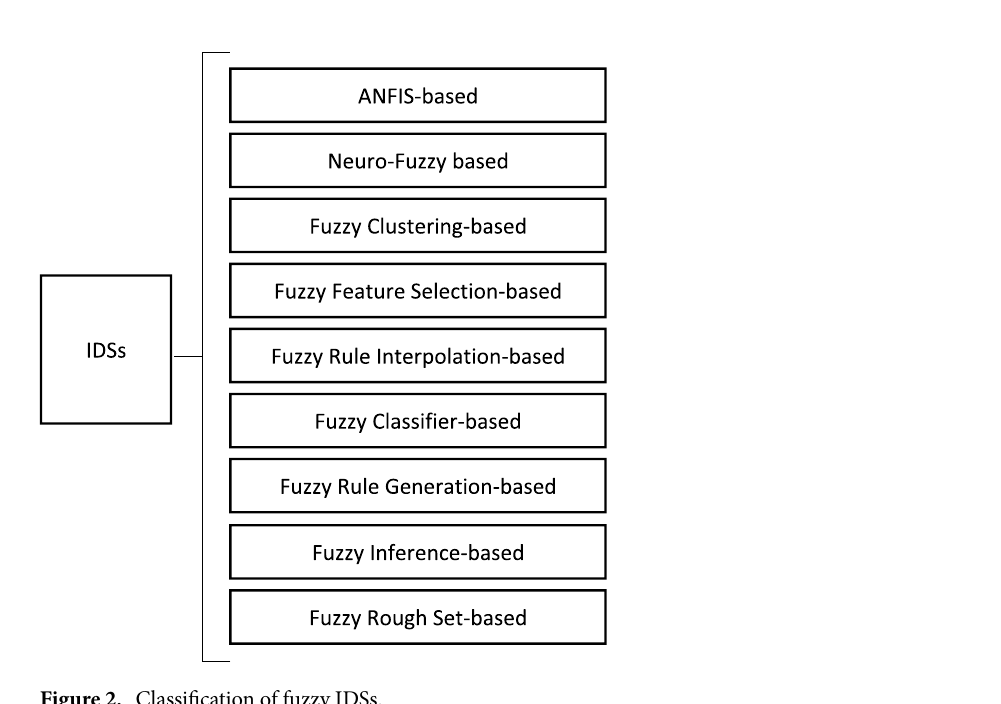
Figure 2. Classification of fuzzy